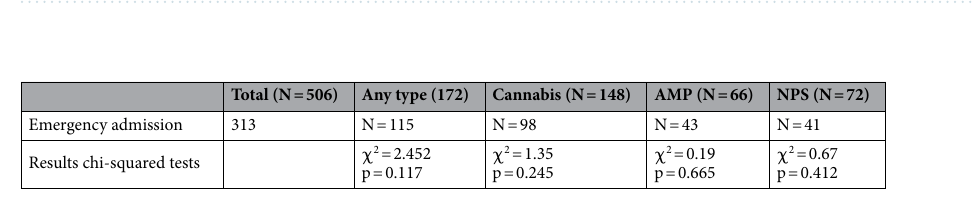
Table 3. Taking illicit substances according to age and sex. Significant values are in bold.